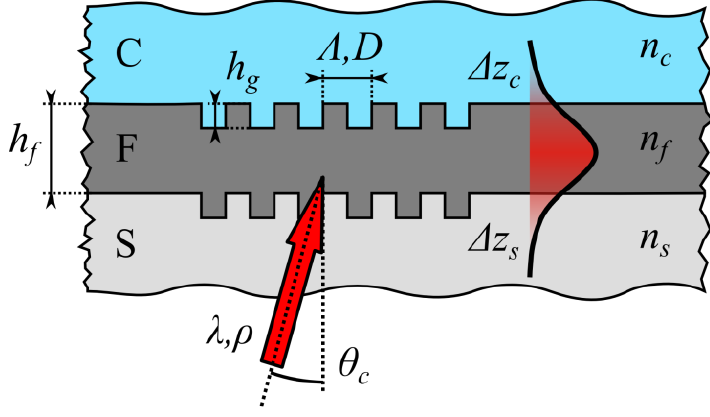
Figure 1. Schematic representation of a waveguide grating coupler, consisting of a substrate S , waveguide film F with a layer thickness of h f and cover layer C with refractive indices n s , n f and n c , respectively. A corrugated grating with a depth of h g , period Λ and duty-cycle D acts as a coupling element for coherent light with wavelength λ , polarization ρ incident at an angle θ c , thereby creating a guided mode with evanescent tails with penetration depths Δz c and Δz s